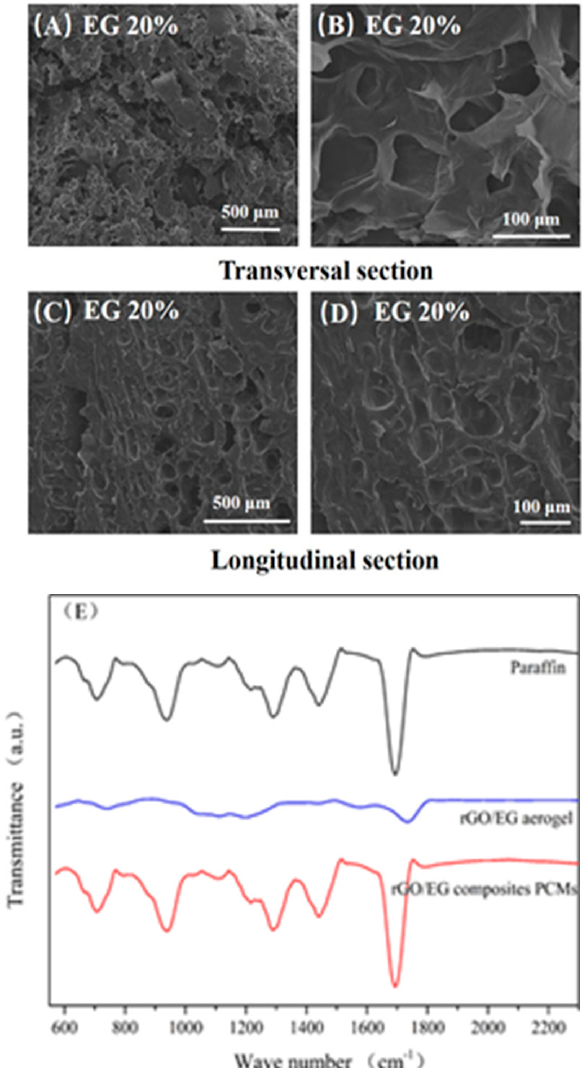
Figure 6. SEM photos of composite phase change materials (PCM) ( A – D ) and FTIR spectra of rGO/EG aerogel, paraffin and composite PCM ( E ).